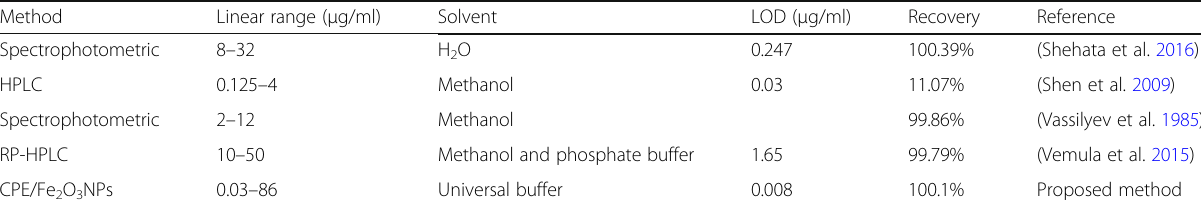
Table 1 Comparison of the proposed method with other methods Method